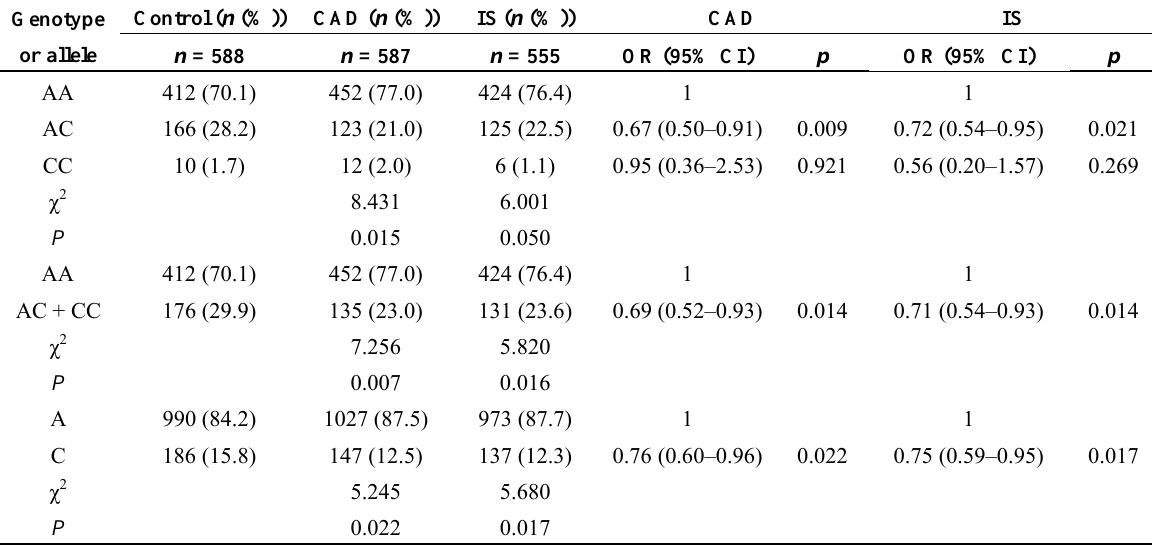
Table 2. Genotypic and allelic frequencies and the risk of coronary artery disease (CAD) and ischemic stroke (IS).